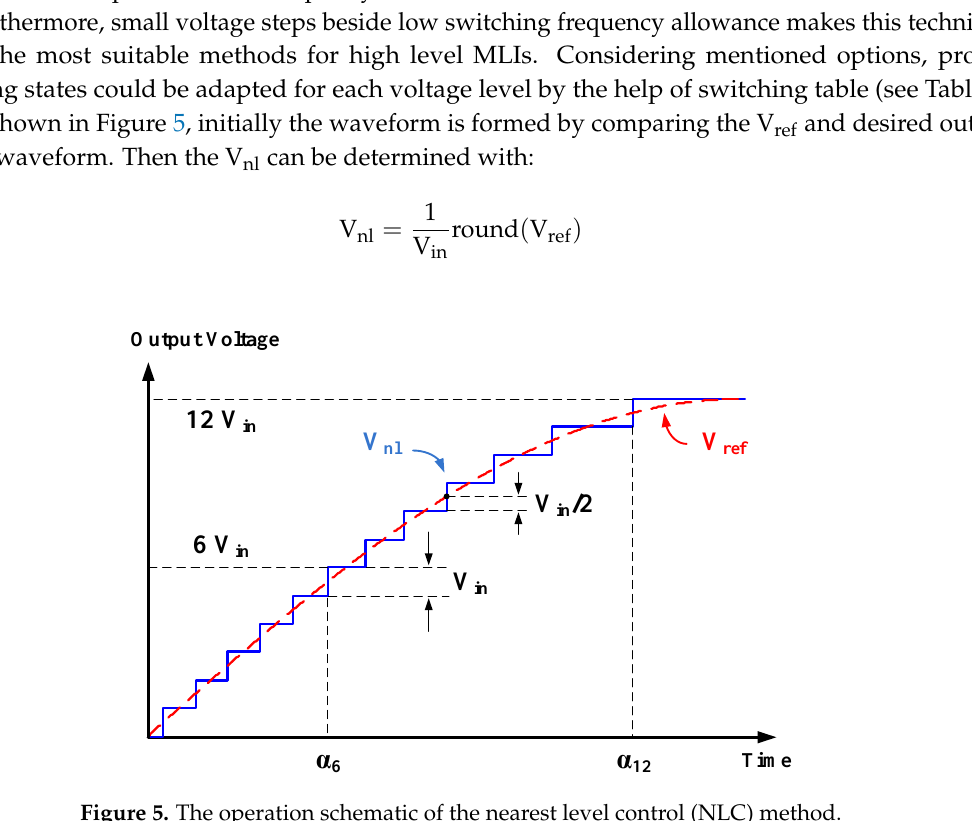
Figure 5. The operation schematic of the nearest level control (NLC) method.